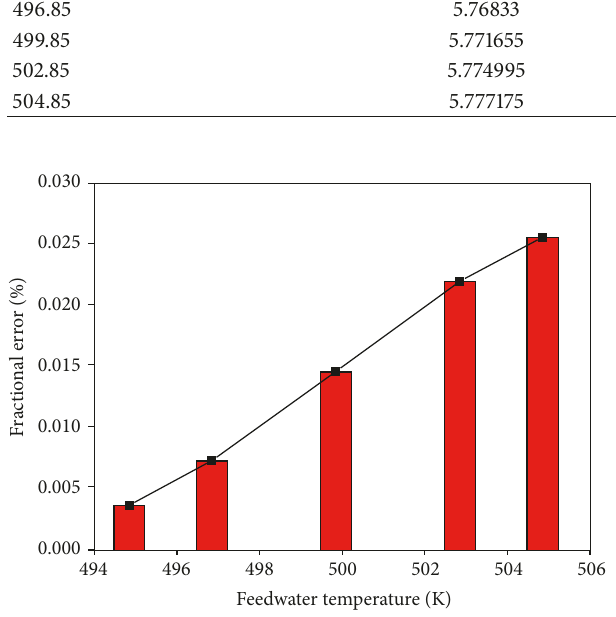
Figure 12: The influence of feedwater temperature on the fractional error between calculated and designed SG outlet temperature.